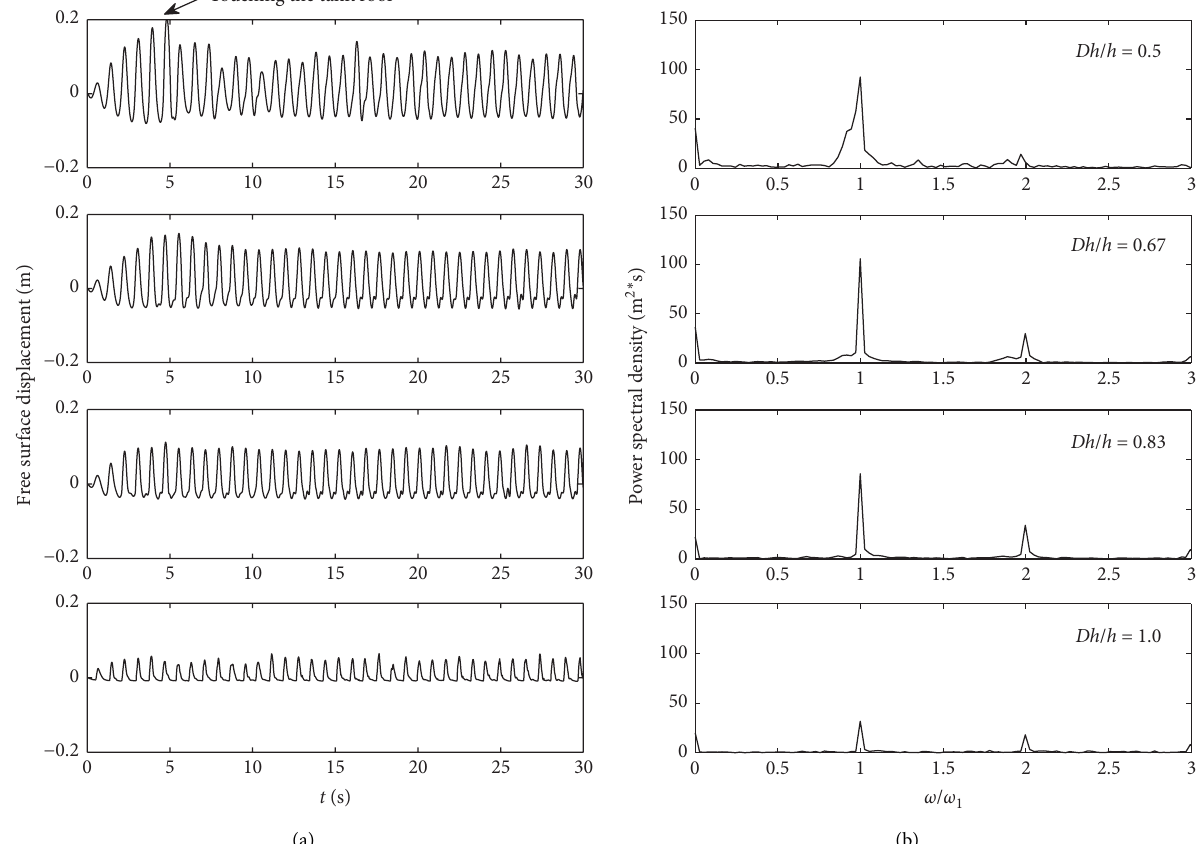
Figure 9: (a) Numerical free surface displacement and (b) the corresponding power spectra at Gauge 1 for different horizontal baffle heights.